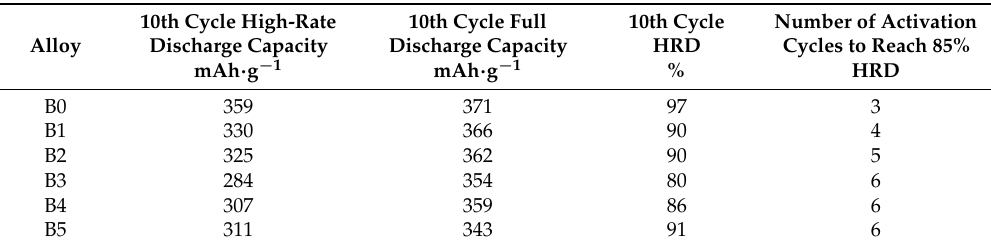
Figure 7. Activation behaviors observed from ( a ) half-cell capacity measured at 4 mA·g ‒ 1 and ( b ) half-cell high-rate dischargeability (HRD) for the first 13 electrochemical cycles. Table 5. Summary of the RT electrochemical half-cell results.